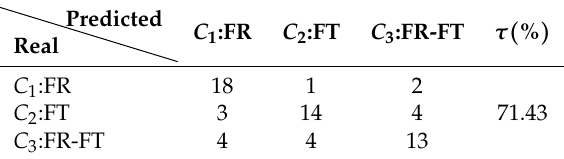
Table 3. The confusion matrix corresponding to the proposed Kohonen three class classification method. τ ( % ) corresponds to the classification accuracy. Predicted C 1 :FR C 2 :FT C 3 :FR-FT Real